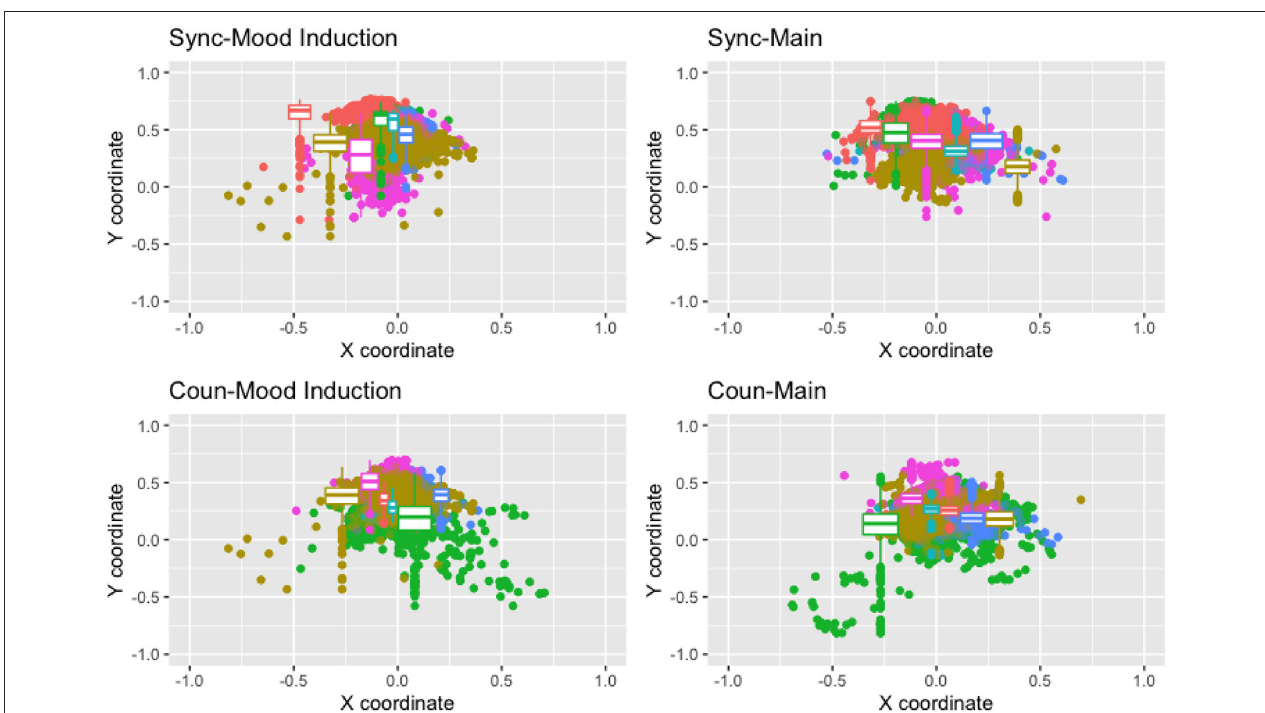
FIGURE 7 | Gaze distribution in the two tasks ( left: mood induction; right: main task). The colors identify the participants in the two groups ( top: sync; bottom: coun).